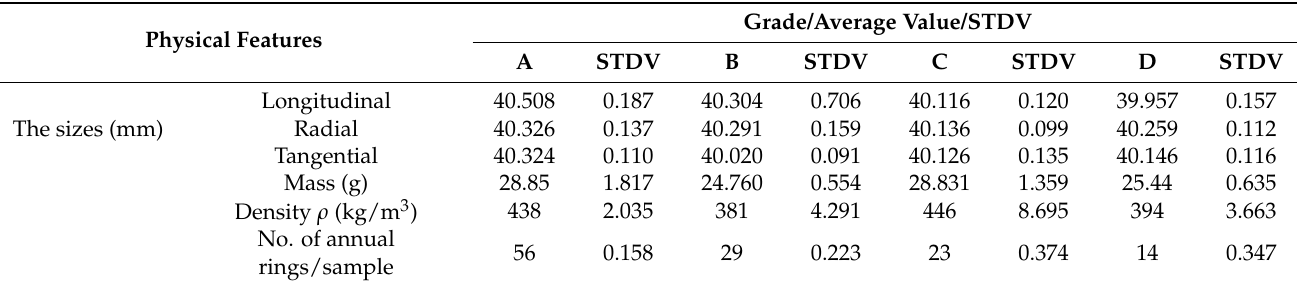
Table 1. The physical features of the spruce wood samples.